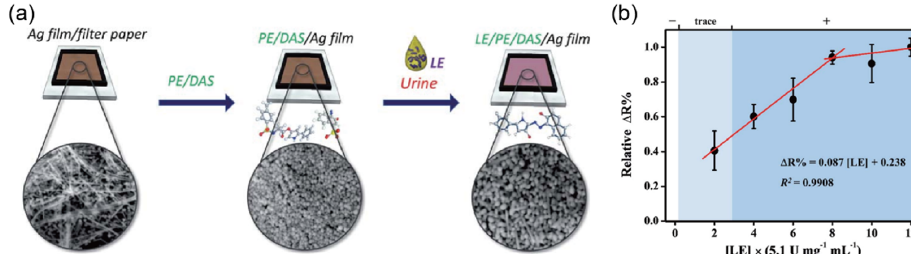
Figure 9. Selective detection of leukocyte esterase (LE) in clinical samples using electrochemical biosensors ( a ) Schematic diagram illustrating the experimental design with a chemiresistive method for the quantitative detection of LE in urine. ( b ) Relative resistivity calibration curve of LE-PAD toward different LE concentrations. The limit of detection was 1.91 (×5.1 U mg − 1 mL − 1 ; 20 WBC per mL). All resistivity responses are presented as mean values ± standard deviation (SD), n = 3, and the corresponding points are overlaid. The correlation of the resistivity response was 99% (reprinted with permission from Ref. [45]; copyright 2020, RSC).